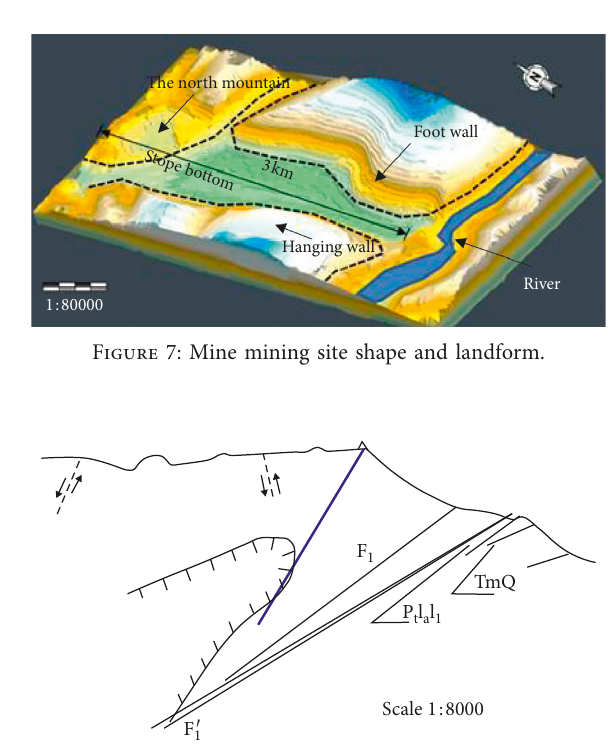
Figure 8: Reverse anticline shape and fault structure in the mining area.